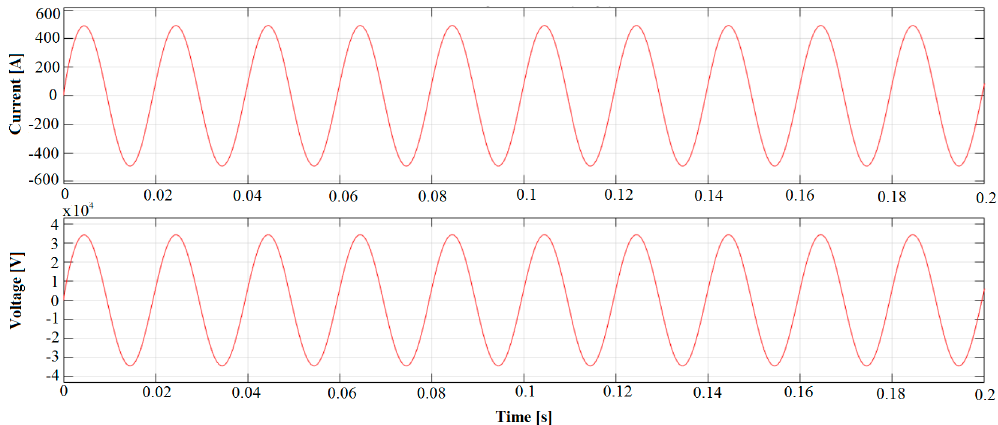
Figure 8. Voltage and current drawn by a High Speed Train (HST) on a high-speed line with no charging stations.